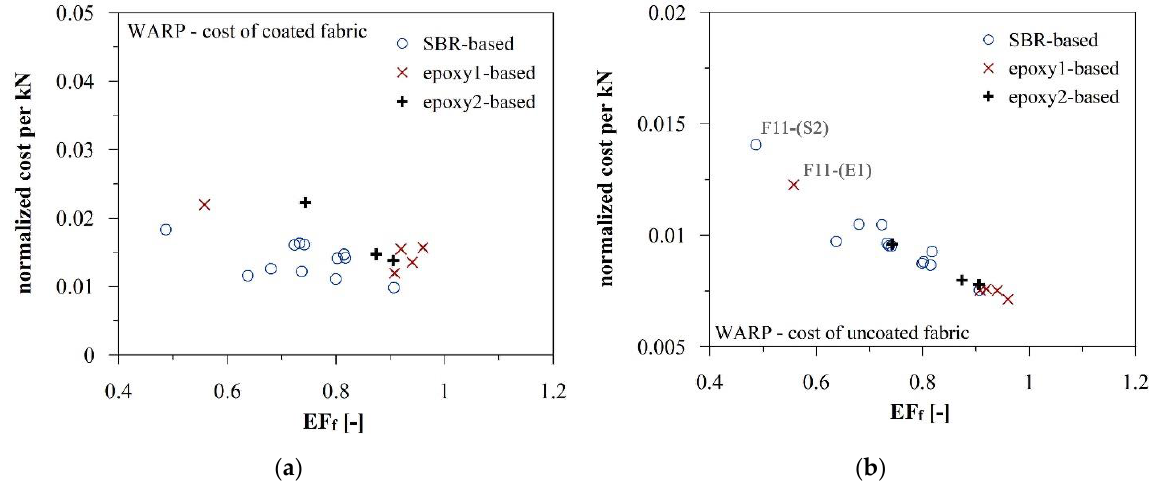
Figure 10. Normalized cost per kN vs. fabric efficiency, EF f : cost of the coated ( a ) and of the uncoated fabrics ( b ).